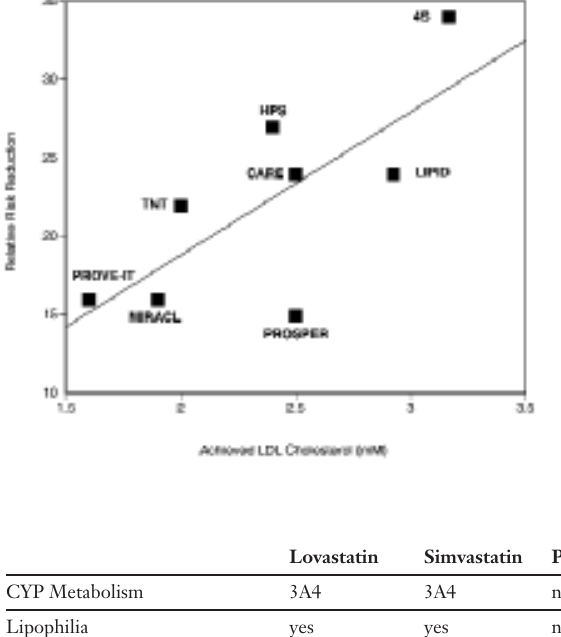
Pharmacological properties of